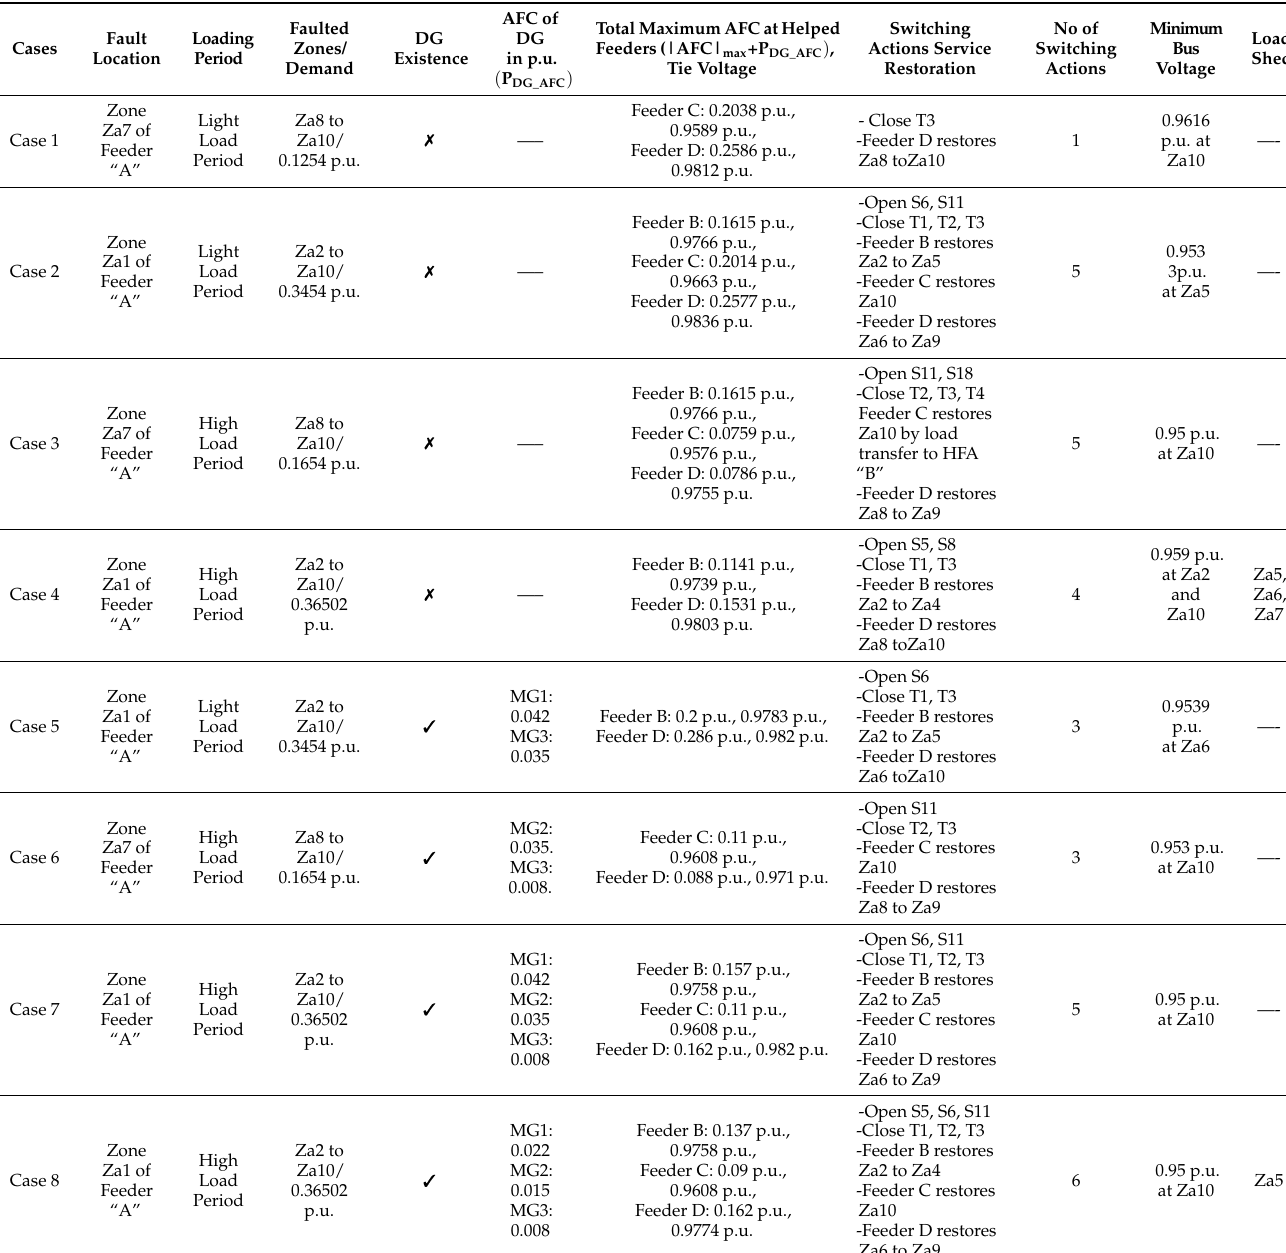
Table 1. Summary of service restoration results for the eight simulation